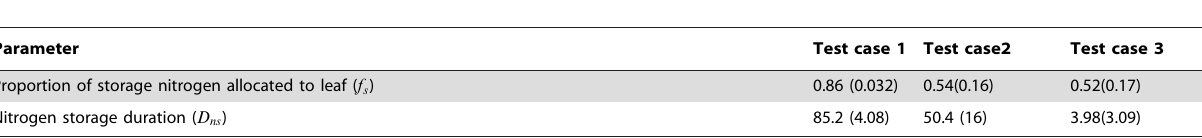
Table 2. Fitted parameter values for test cases 1–3 using Metropolis-Hasting